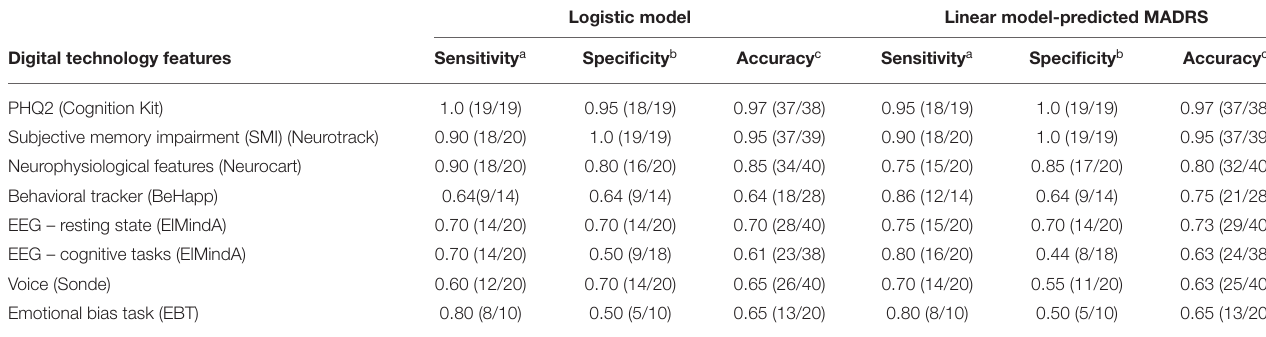
TABLE 3 | Classification analysis using logistic model and linear model-predicted MADRS using different digital technology